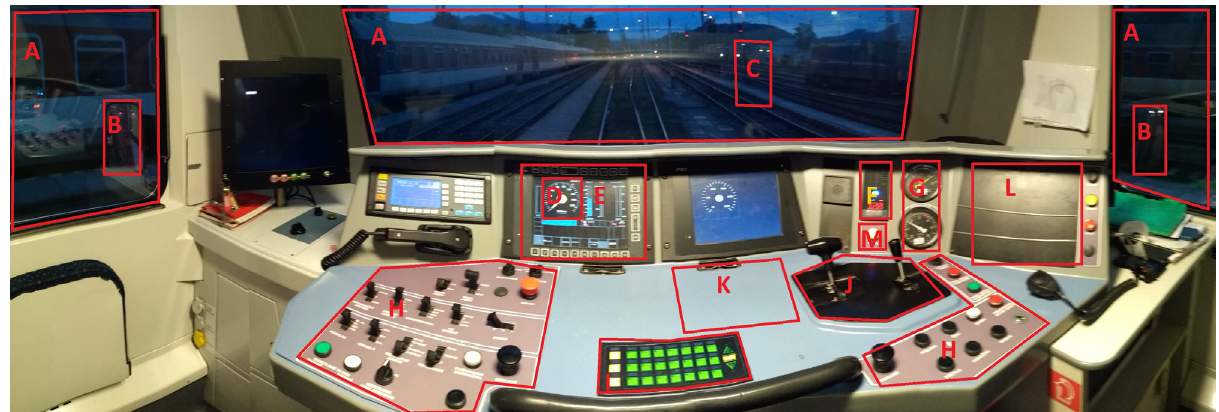
Figure 2: EPJ 671 – cabin view with monitored part/panels of the cabin